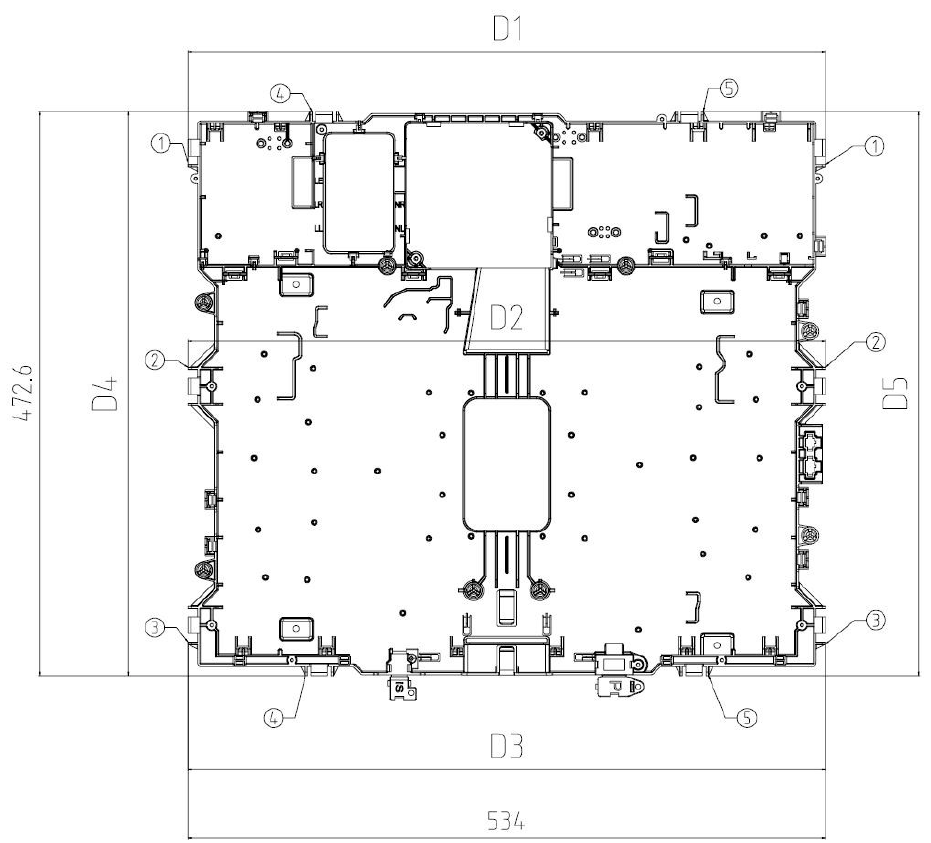
Figure 2. Detail of the locating areas of the part from which dimensions Di (mm) are defined.